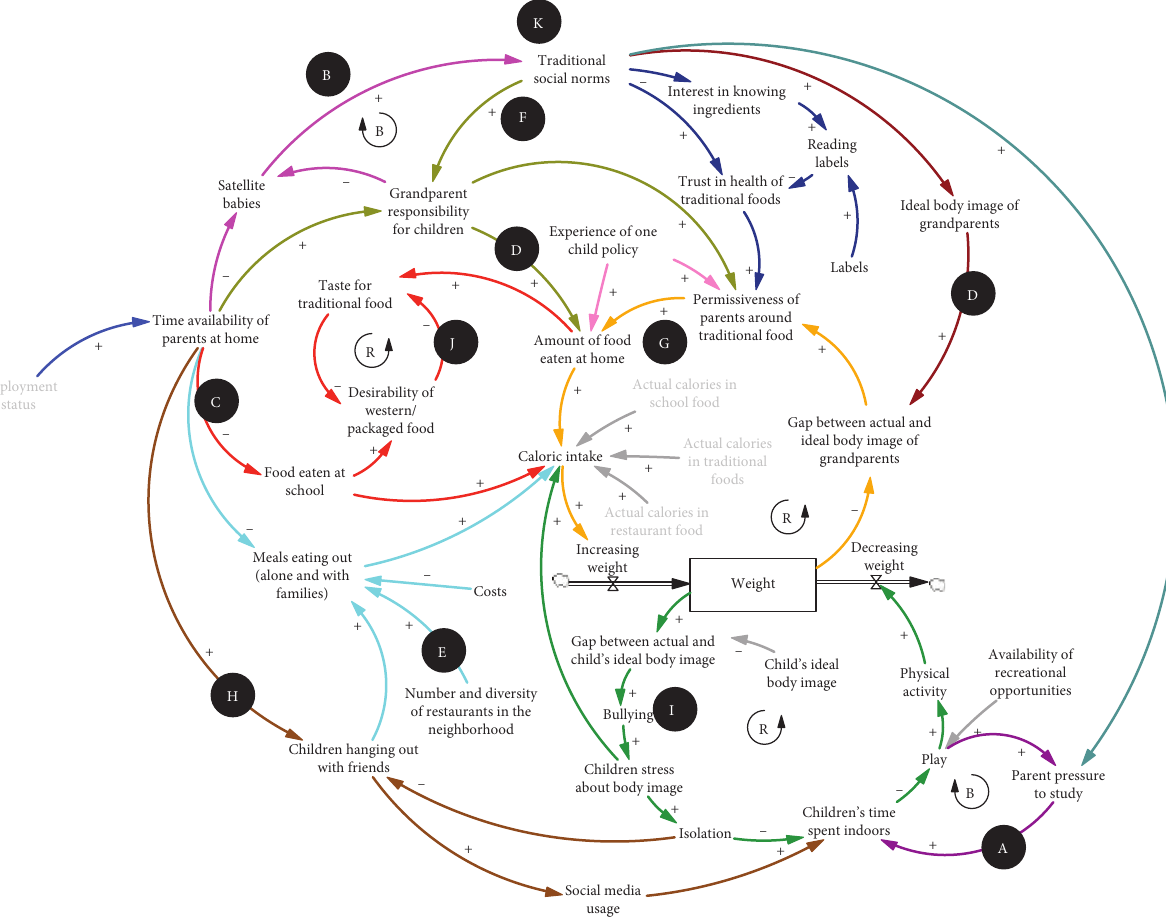
Figure 1: Causal loop diagram (CLD) of childhood obesity in the sociocultural context of the community in Manhattan’s Chinatown. R and B refer to reinforcing and balancing feedback loop, respectively. This CLD presents the local residents’ view of childhood obesity- related factors and links among them. A through K illustrate subsystems of factors, links, and feedback